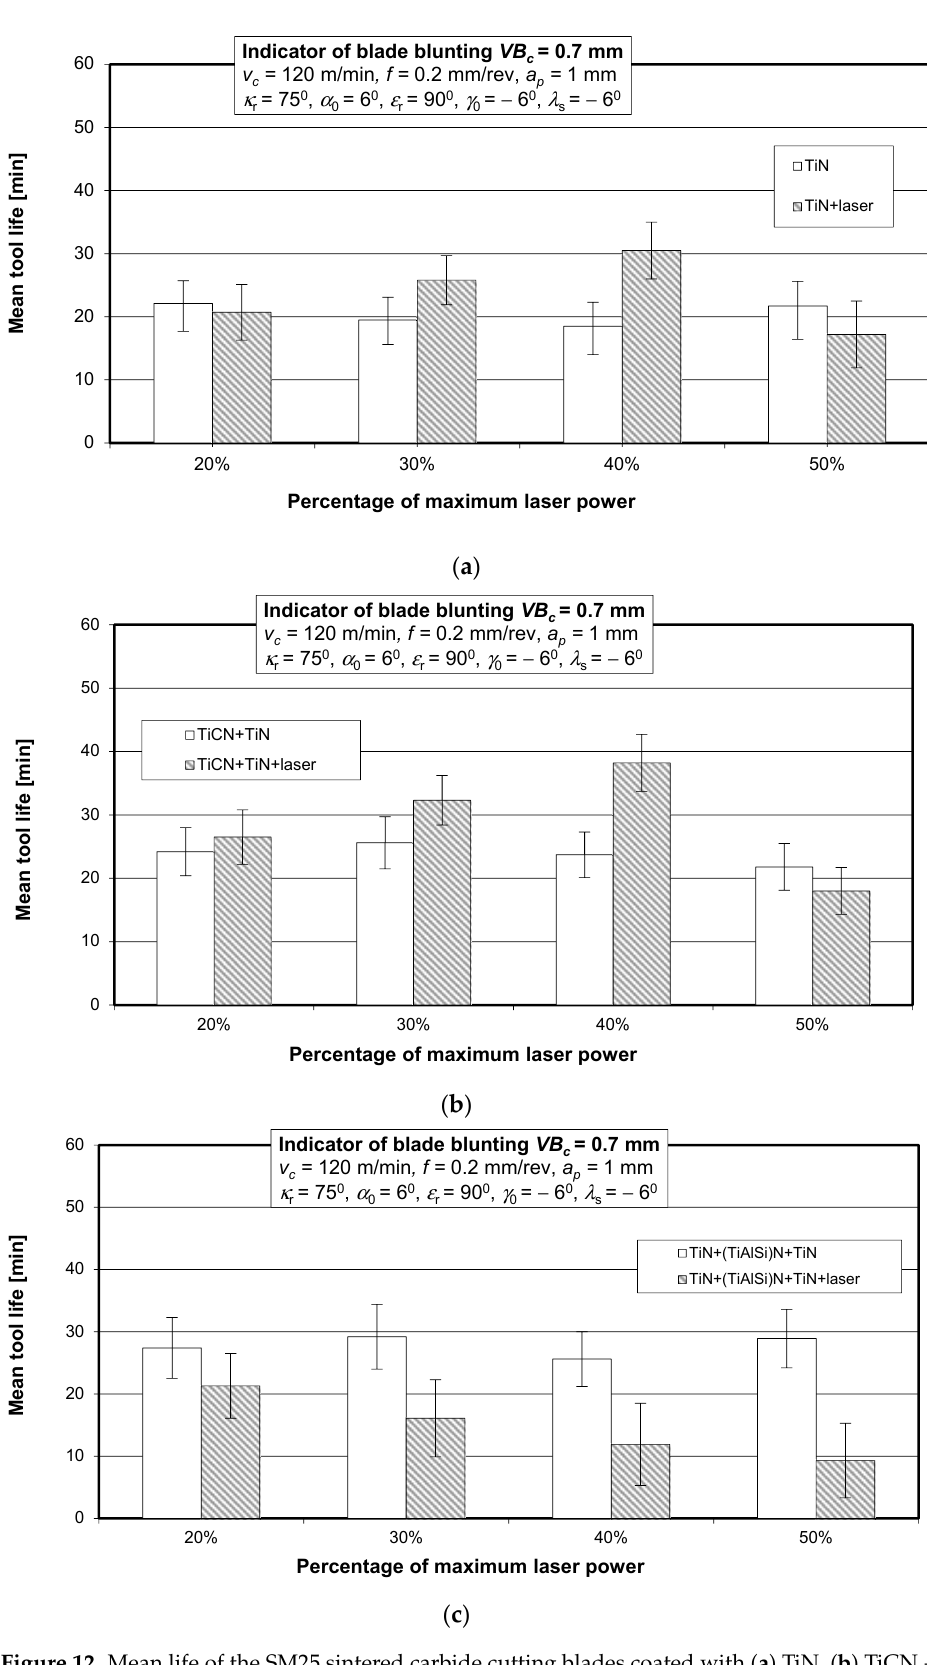
Figure 12. Mean life of the SM25 sintered carbide cutting blades coated with ( a ) TiN, ( b ) TiCN + TiN, and ( c ) TiN + (TiAlSi)N + TiN before and after laser heating with different laser power values, obtained in a turning process of 35HGS alloy steel.